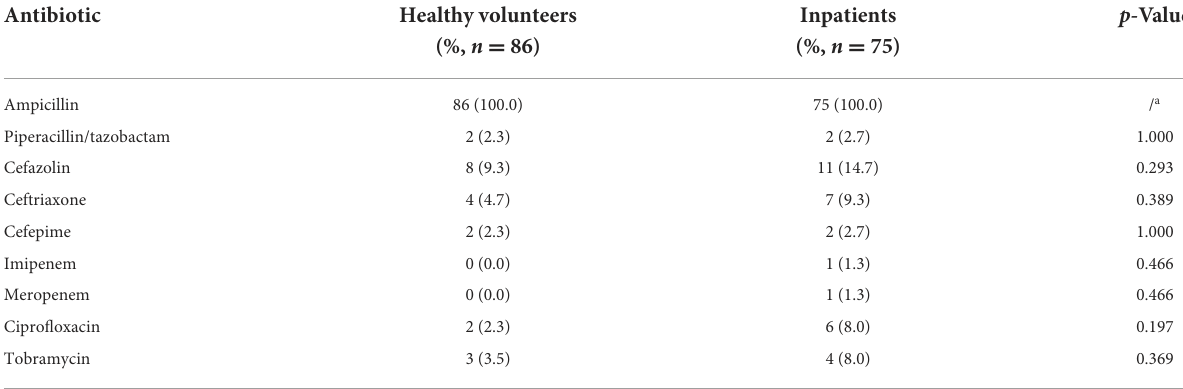
TABLE 5 The resistance rates of terW + KP isolated by MCKT medium from healthy volunteers and inpatients.